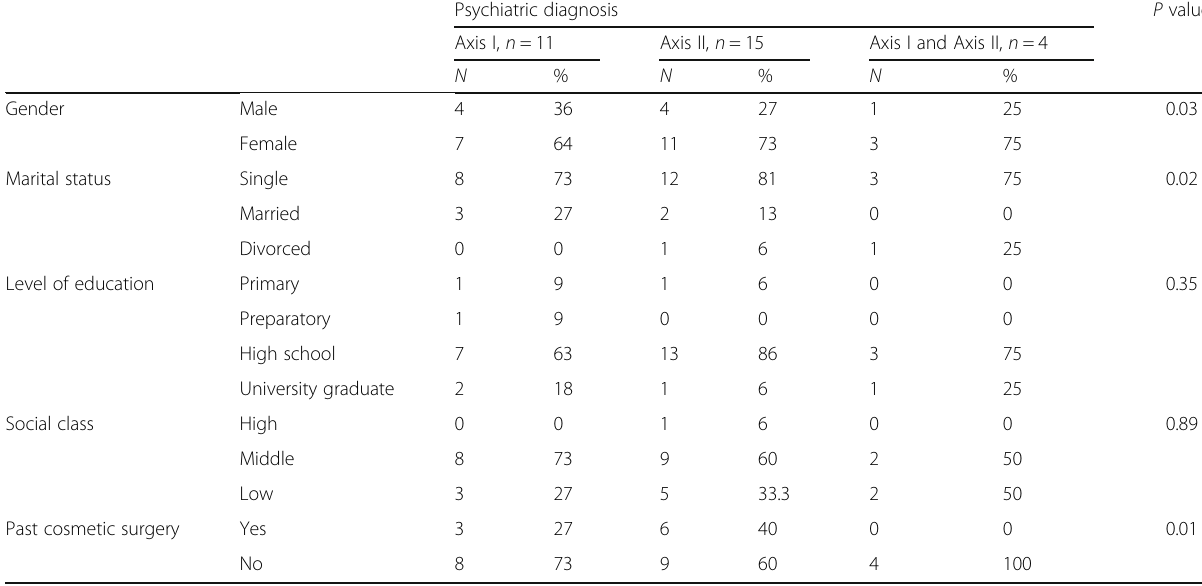
Table 4 Patients with psychiatric morbidity who seek rhinoplasty